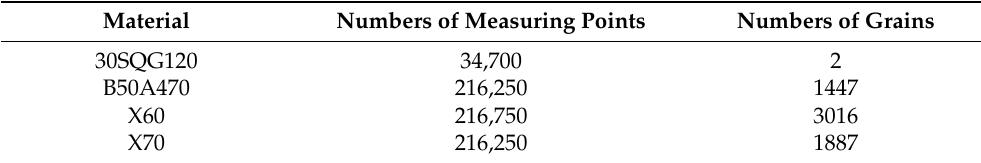
Table 3. Number of grains determined by EBSD microtexture measurement.